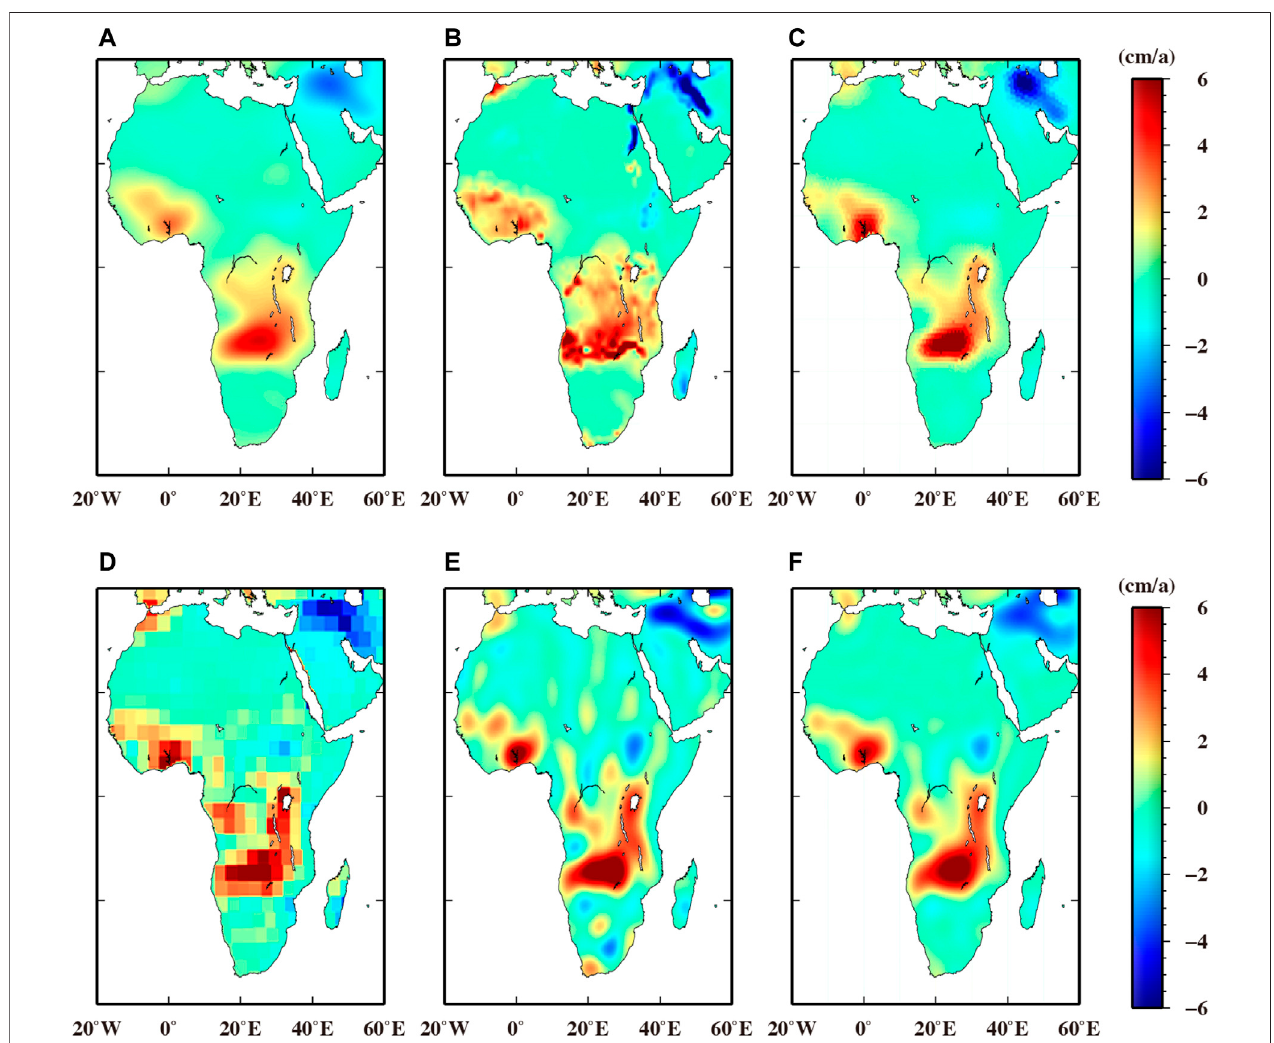
FIGURE 10 | Trends (cm/a) derived from different solutions: (A) CSR Tellus Mass Grid, (B) CSR Tellus Mass Grid with scale factor, (C) CSR mascon solution, (D) JPL mascon solution, (E) general forward modeling method, (F) improved forward modeling method.